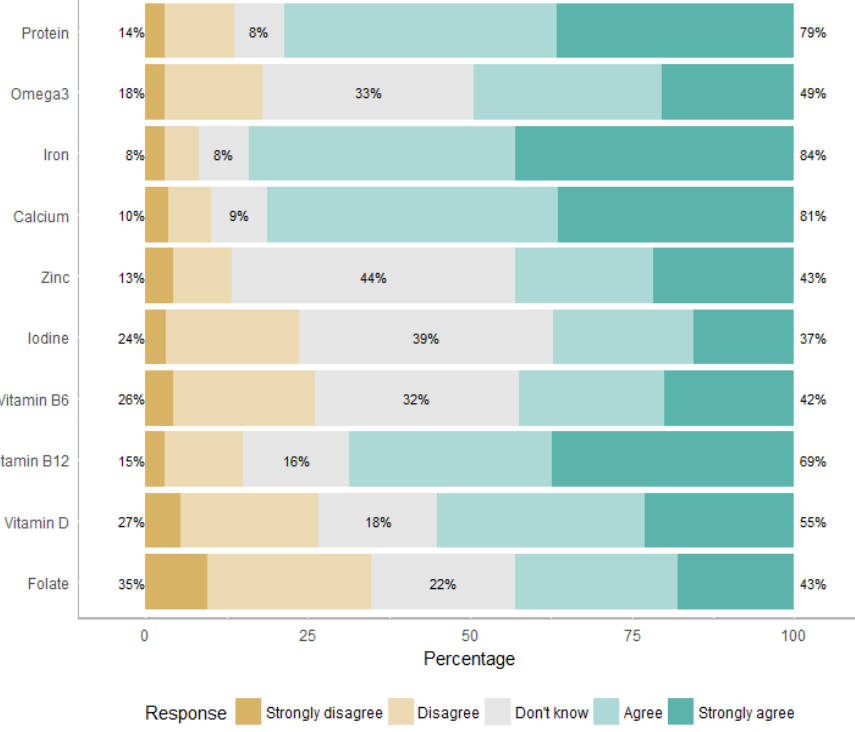
Figure 2. Perceived risk of deficiencies related to a vegan diet.